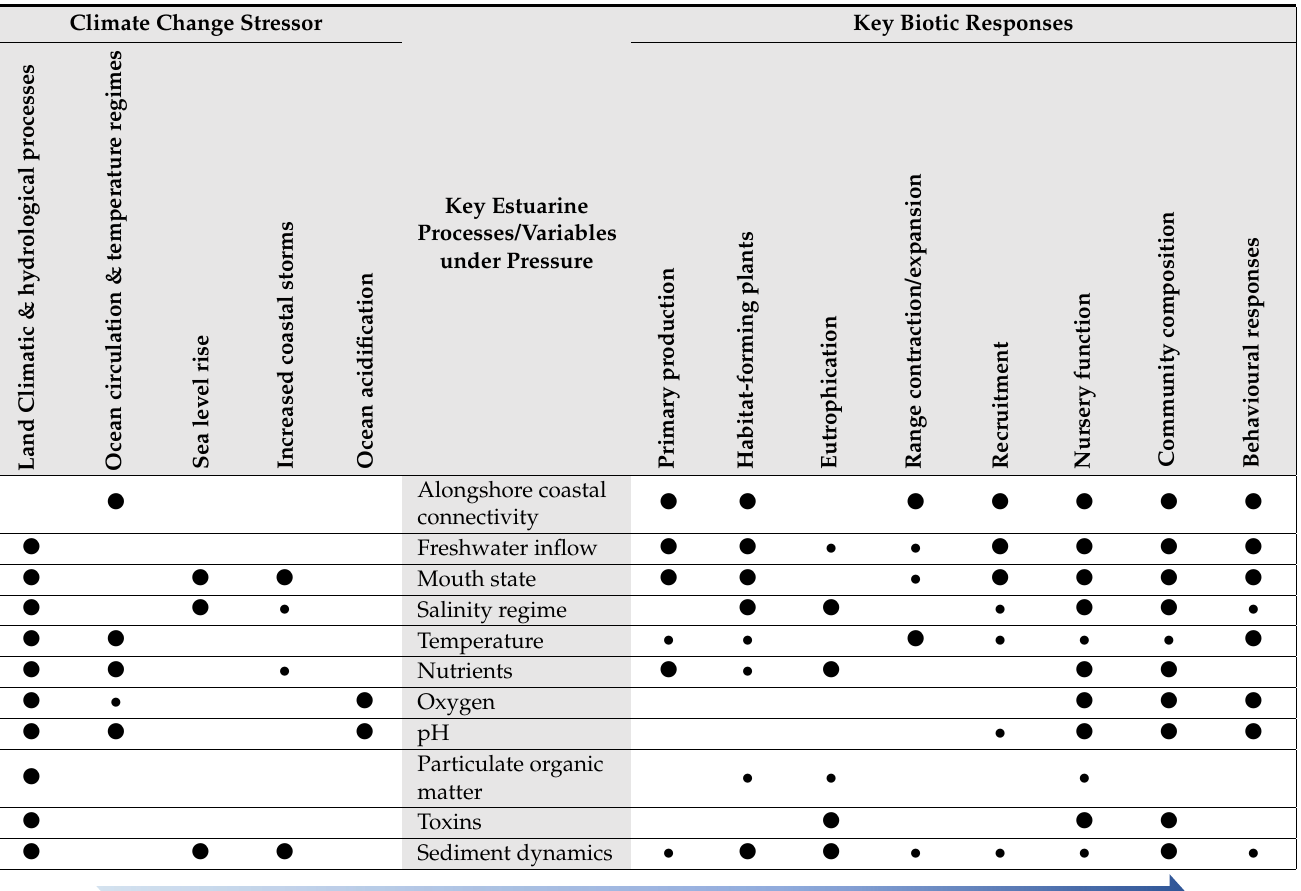
Table 1. A summary of key Climate Change stressors, important estuarine processes, and variables affected, as well as associated biotic responses (large/small Circle = high/medium degree of change or vulnerability).